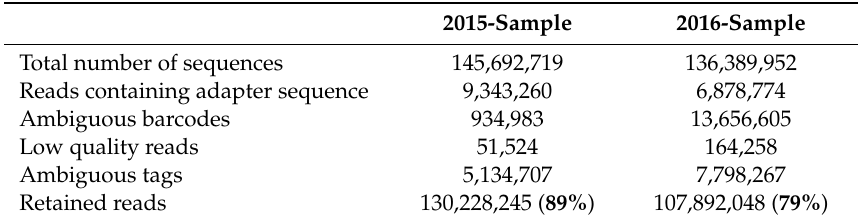
Table 1. Sequencing results from 2015-Sample and 2016-Sample GBS